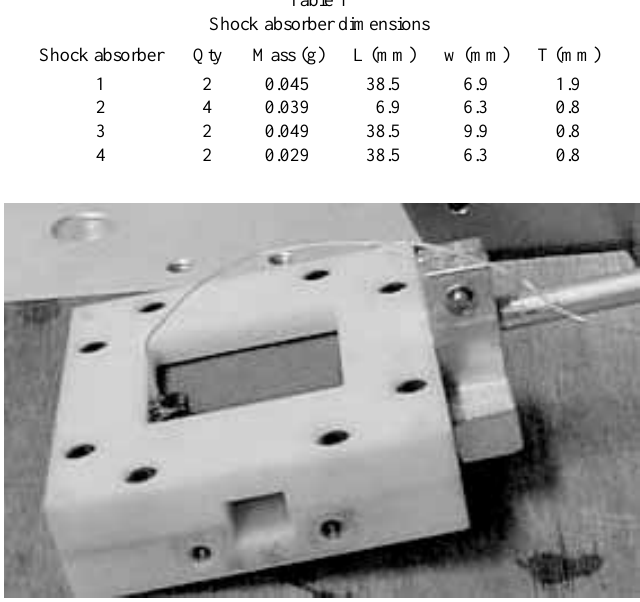
Fig. 9. Clamp of the tilt tester for shock absorber